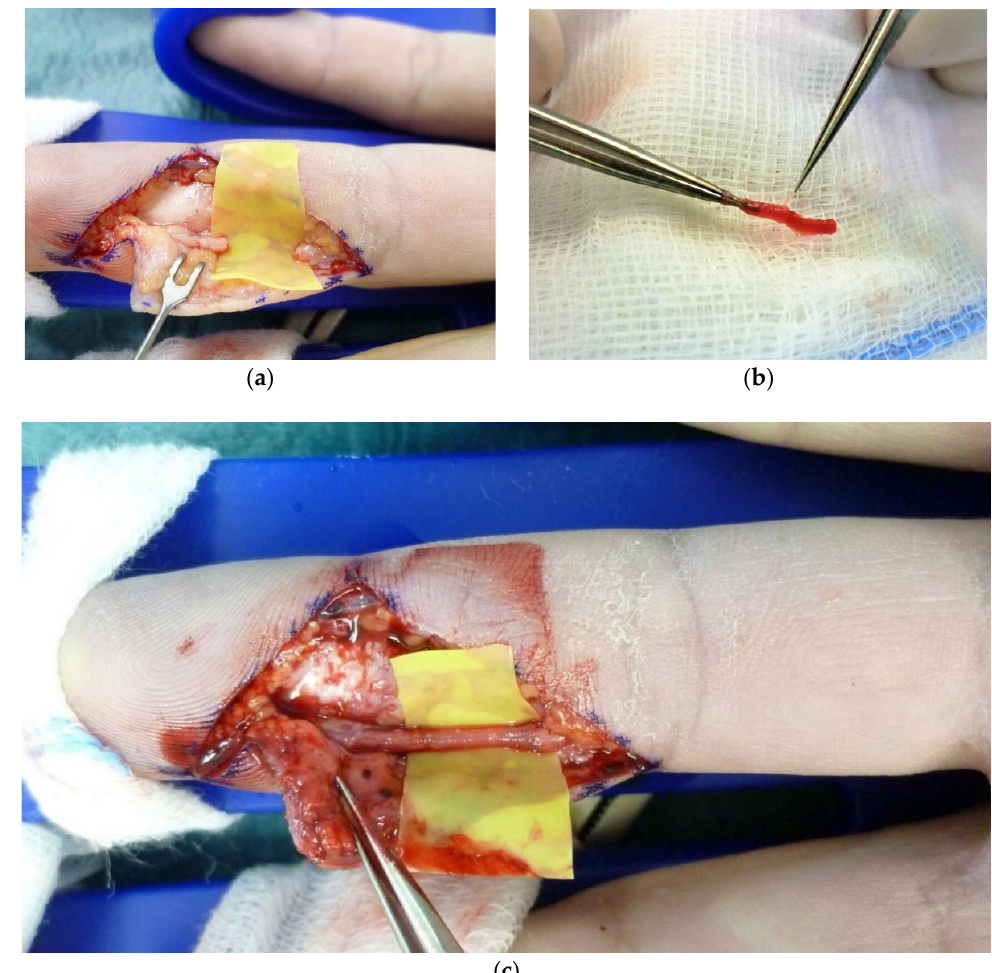
Figure 1. Intraoperative photographs demonstrating the reconstruction of the radial digital nerve of the ring finger by MVC. ( a ) Resection of the neuroma and measurement of the residual nerve defect. ( b ) Fashioning of the MVC by pulling the vein over the muscle fibres. ( c ) Completed nerve reconstruction with MVC in place.